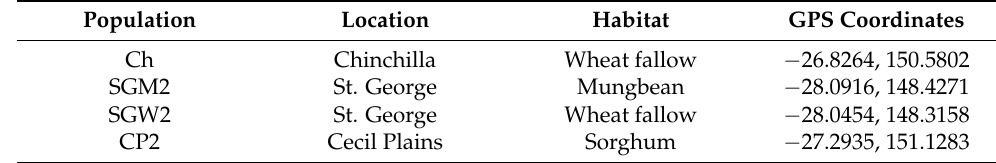
Table 1. Populations of Chloris virgata collected from different regions of Queensland, Australia. Population Location Habitat GPS Coordinates Ch Chinchilla Wheat fallow − 26.8264, 150.5802 SGM2 St. George Mungbean − 28.0916, 148.4271 SGW2 St. George Wheat fallow − 28.0454, 148.3158 CP2 Cecil Plains Sorghum − 27.2935,